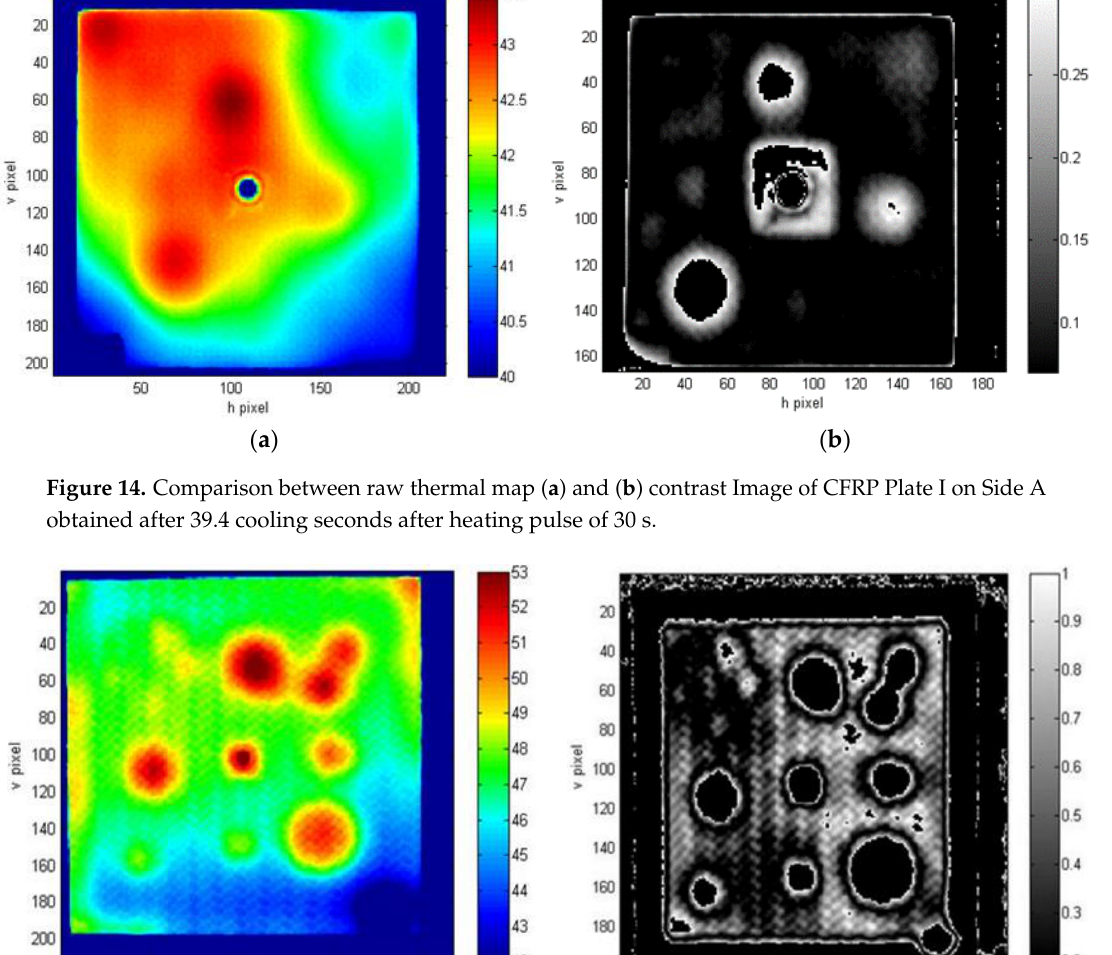
( b ) Figure 13. ( a ) Example of comparison between raw thermal map and ( b ) contrast map of CFRP Plate I/Side B. Despite the heating not ideal, the contrasts map allows identification even the smallest defects of 5 mm diameter in a single specimen map (top left). The proposed contrast allows better evaluation of internal defects and is physically explained by the fact the thermal properties of defects are different from those of the surrounding material. Contrast mapping has been optimized in order to highlight the most reliable boundary for